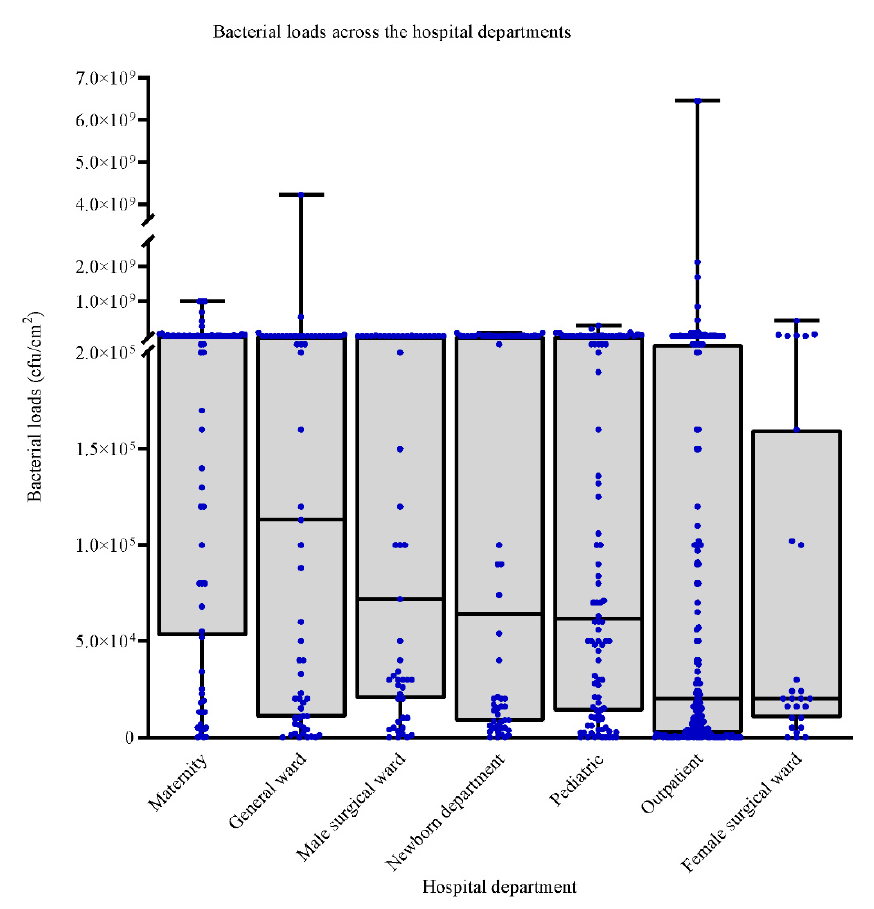
Figure 2. Median and IQR distributions of bacterial loads across the hospital departments; in the maternity department, the bacterial loads are mostly greater than 2.0 × 10 5 , while in the outpatient and female surgical departments, the bacterial loads are mostly lower than 5.0 × 10 4 . The bacterial loads are disbursed throughout the general wards, male surgical wards, newborns, and paediatric departments.